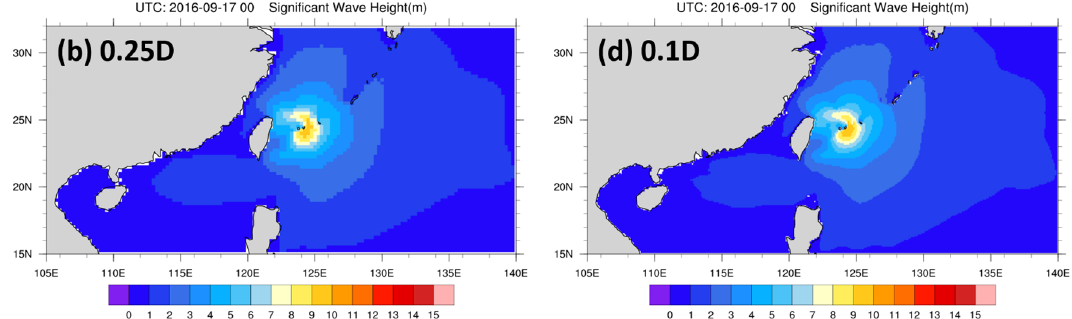
Figure 8. Spatial distribution of Typhoon Malakas significant wave height driven by CFSv2 using the WW3 model with ( a ) 0.50 deg, ( b ) 0.25 deg, ( c ) 0.20 deg, and ( d ) 0.10 deg grid resolutions.